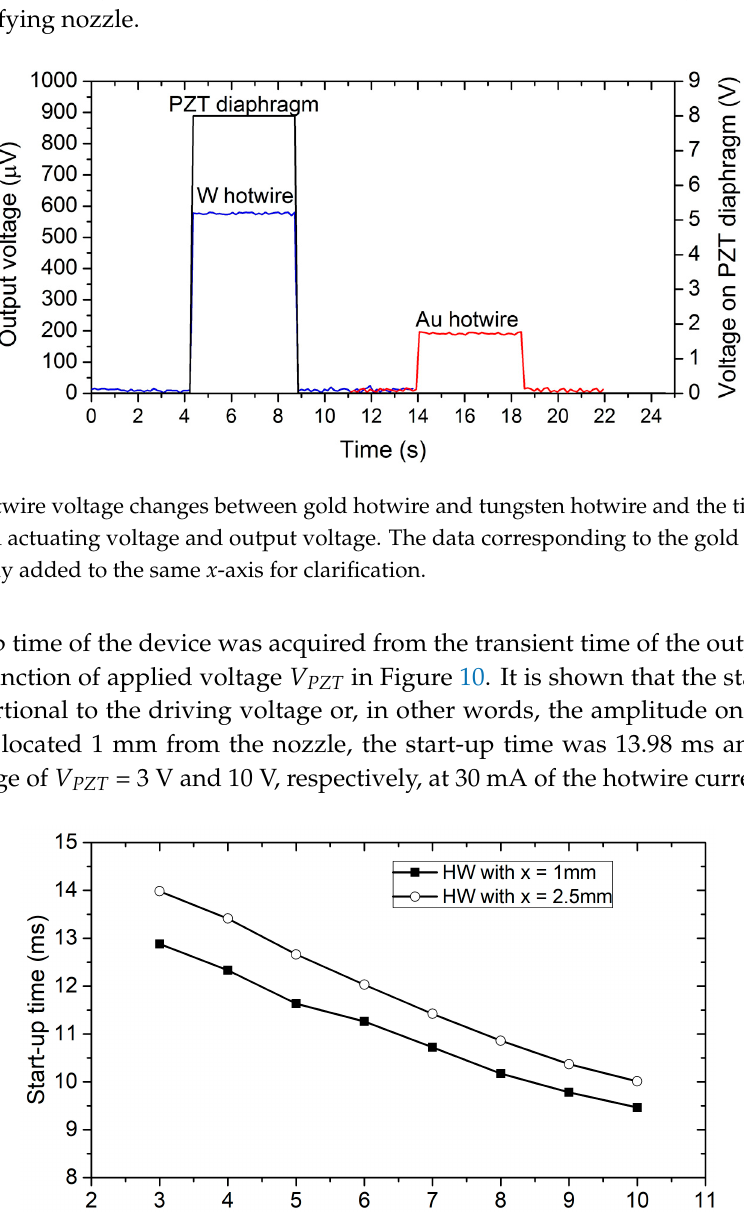
Figure 10. Relationship of the start-up time, measured at hotwire positions of 1 mm and 2.5 mm and driving voltage on the PZT diaphragm. The diaphragm was actuated at the resonant frequency.